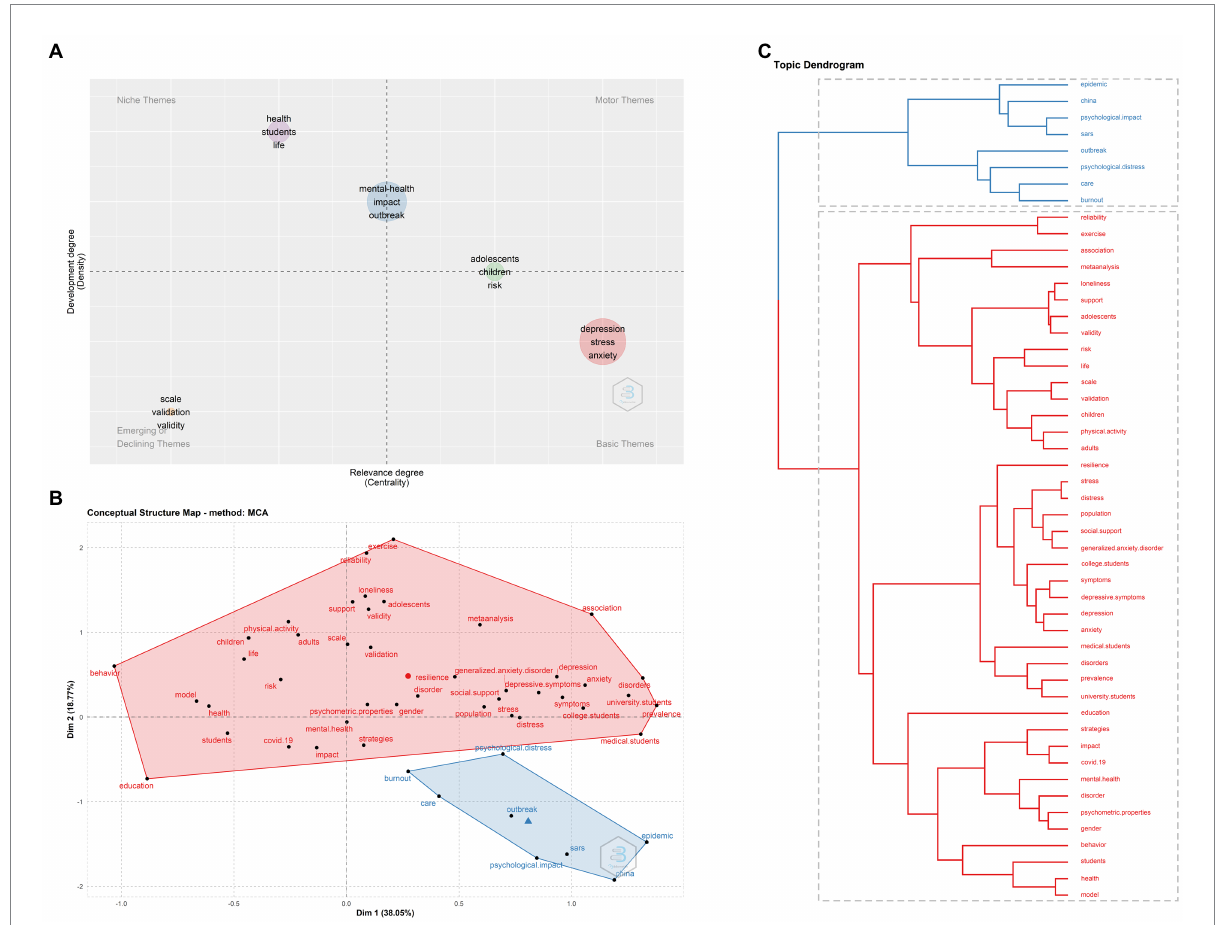
FIGURE 7 Conceptual analysis of mental health of students during COVID-19. (A) Thematic map of related research. (B) Word map of factorial analysis. (C) Topic dendrogram of